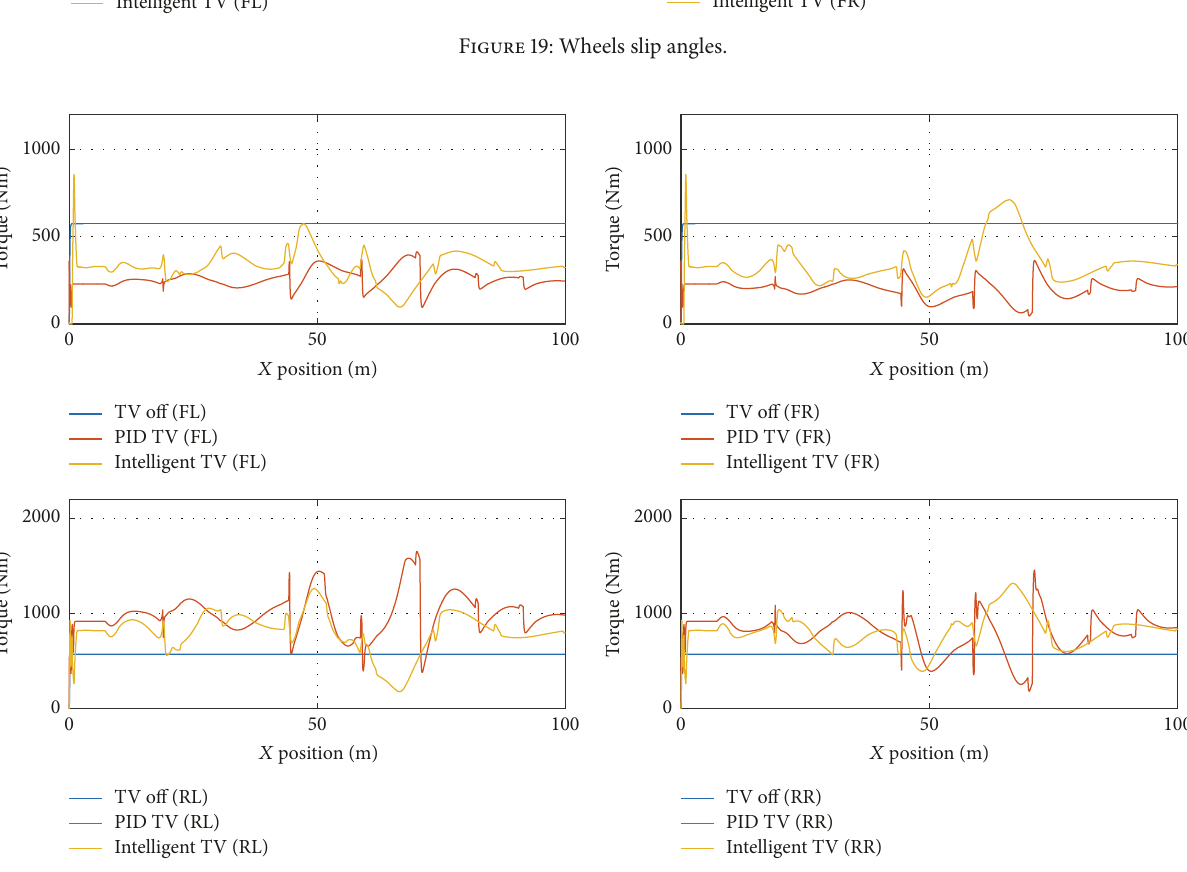
Figure 20: Wheel